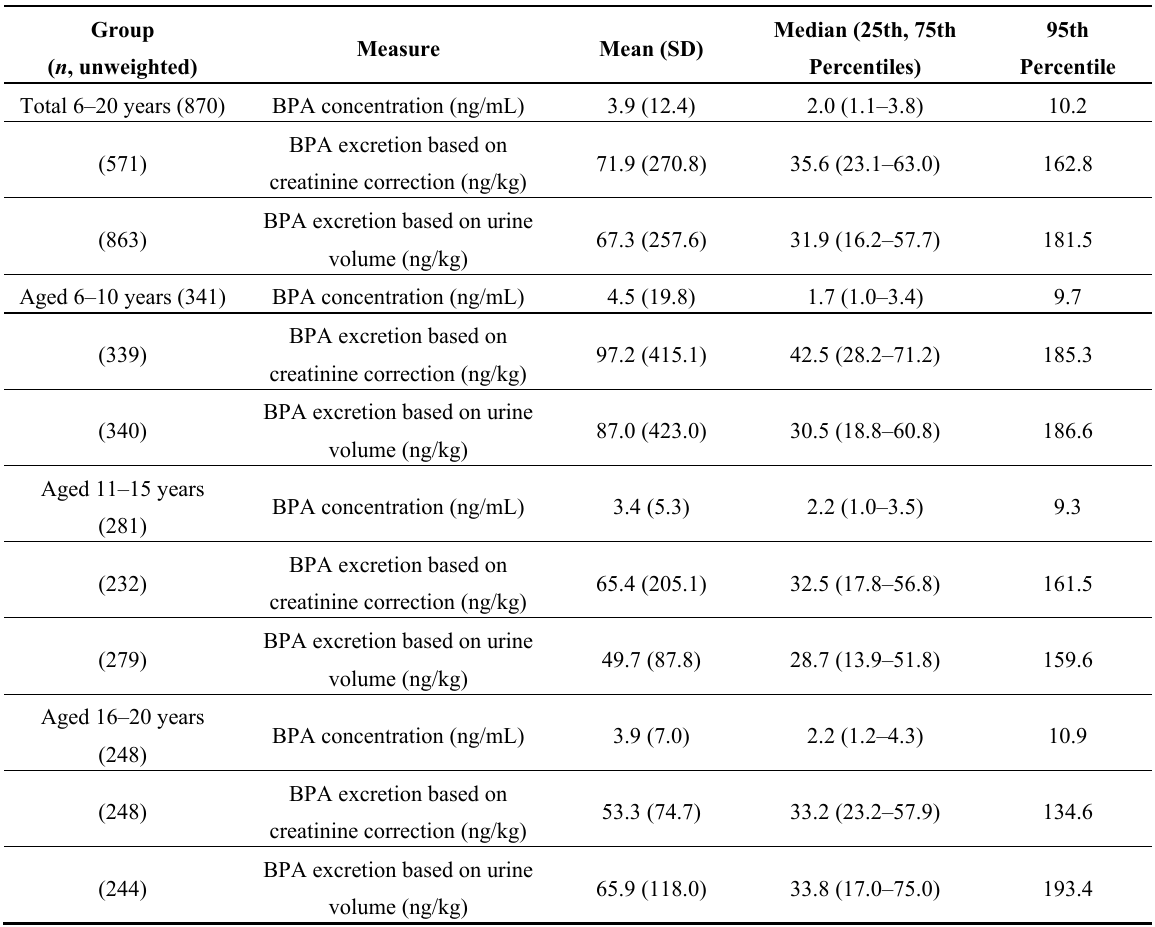
Table A6. BPA urine concentrations and estimated daily excretions based on National Health and Nutrition Examination Survey (NHANES) data, U.S., 2009–2010. All values except n (group size) are weighted for survey sampling.